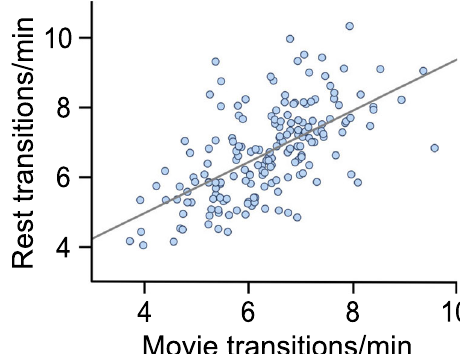
Fig. 5 Transition structure generalizes from stimulus-driven to resting cognition. Participants ’ movie-viewing transition rates correlated with their resting transition rates using a bootstrap correlation approach. Transition rate is calculated by taking the total number of transitions and dividing it by the time